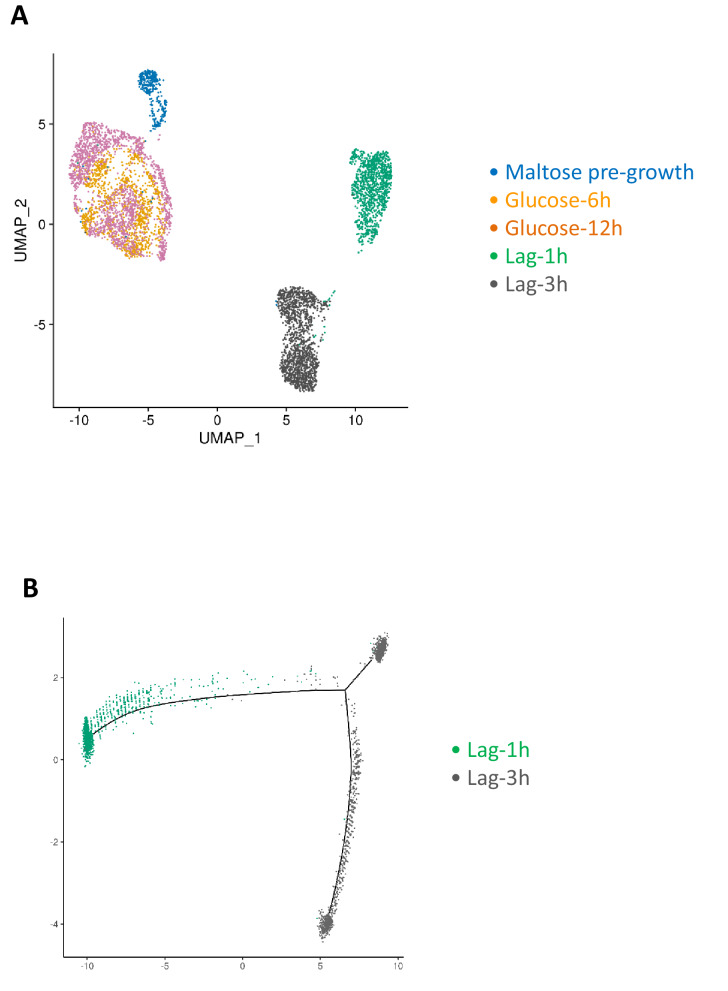
Progression of single-cell transcriptomes during maltose-glucose-maltose shift.(A) Samples for scRNA-seq were collected separately during glucose growth and during the lag phase after the glucose-maltose shift. The cells labeled as maltose pre-growth in the figure consist of a subset of the mix-glucose-maltose sample, namely those cells that express maltose growth markers. If a cell in mix-glucose-maltose sample had at least a total of two transcripts from MAL11, MAL12, MAL31, MAL32 or HXT1 genes, it was labeled as belonging to the maltose pre-growth condition. (B) Pseudo temporal ordering of the cells in lag phase using Monocle package.